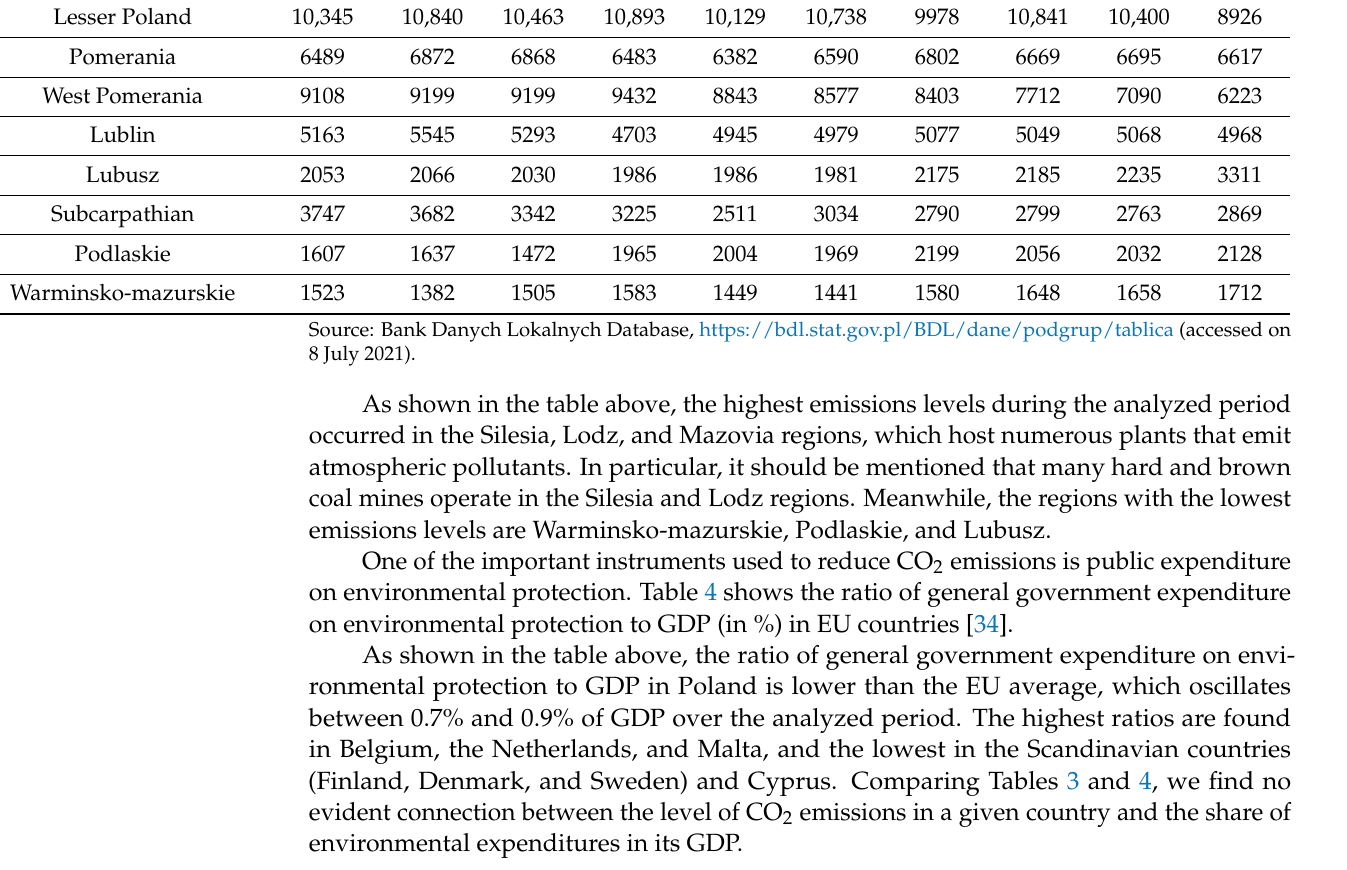
Table 4. General government expenditures on environmental protection to GDP (in %) in EU